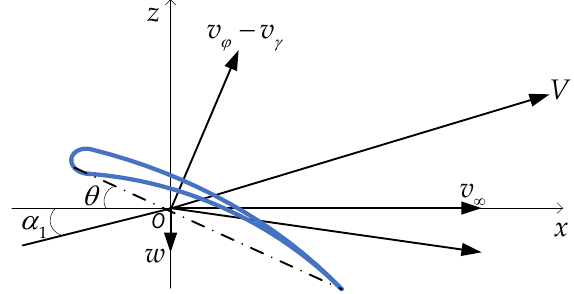
Figure 3. Velocity model for the motion of wing strips.